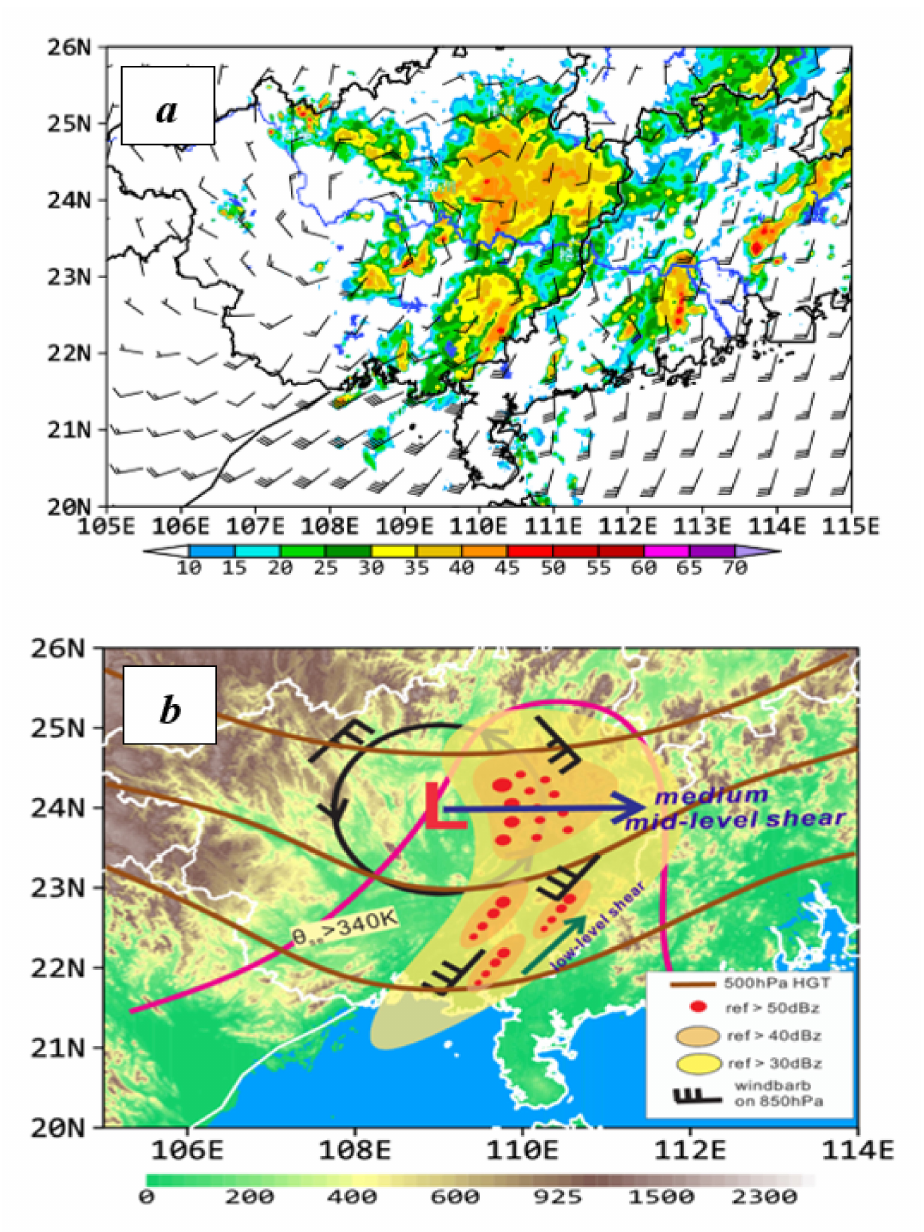
Figure 17. As in Figure 13 but for the comma-shaped MCSs: ( a ) horizontal winds at 925 hPa at 1400 BST and the composite radar reflectivity at z = 1 km at 1240 BST 23 Jun 2012; and ( b ) A conceptual model for the LLV-type WSHR event, with thick arrows in black and green denoting the mid-level and low-level environmental vertical wind shear,